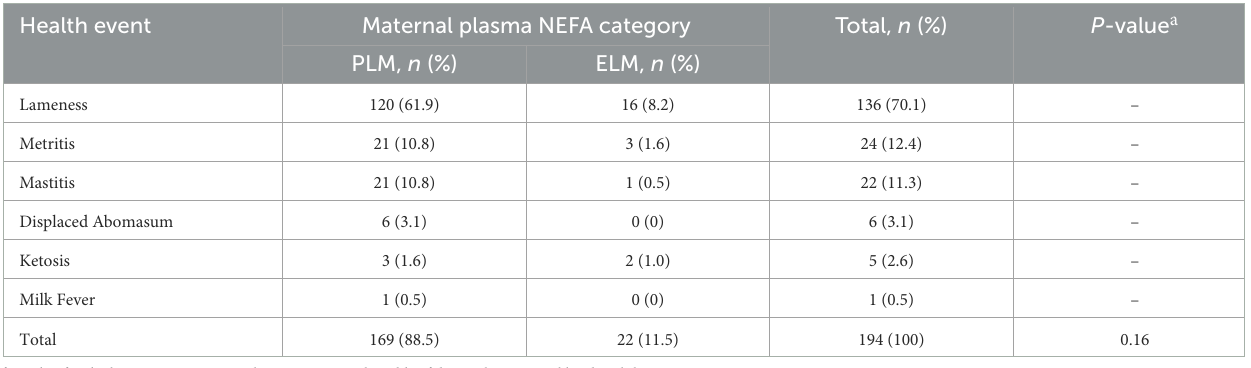
TABLE 4 Frequency of diseases in the first lactation by maternal NEFA category in the late gestation. Health event